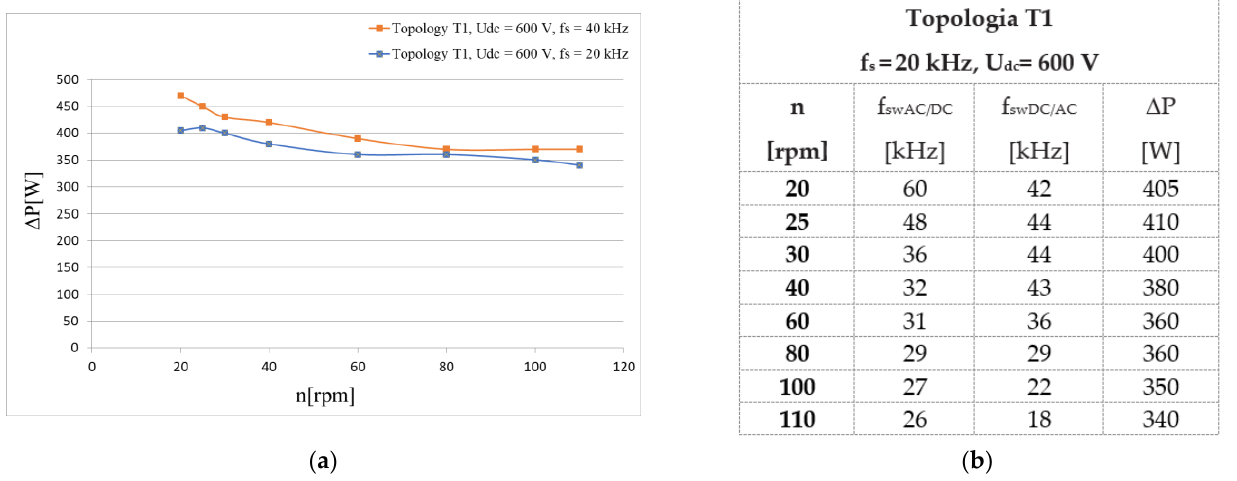
Figure 12. ( a ) Power losses in the topology T1 depending on the sampling frequency for f s = 40 kHz and 20 kHz and ( b ) switching frequency of the f sw transistors in both converters at U dc = 600 V.